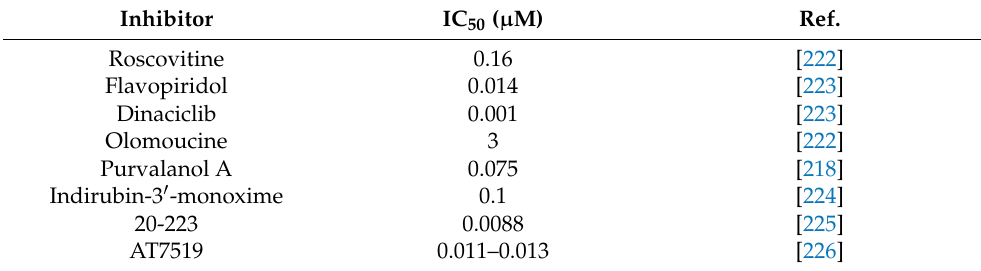
Table 4. IC 50 values of CDK5 inhibitors.